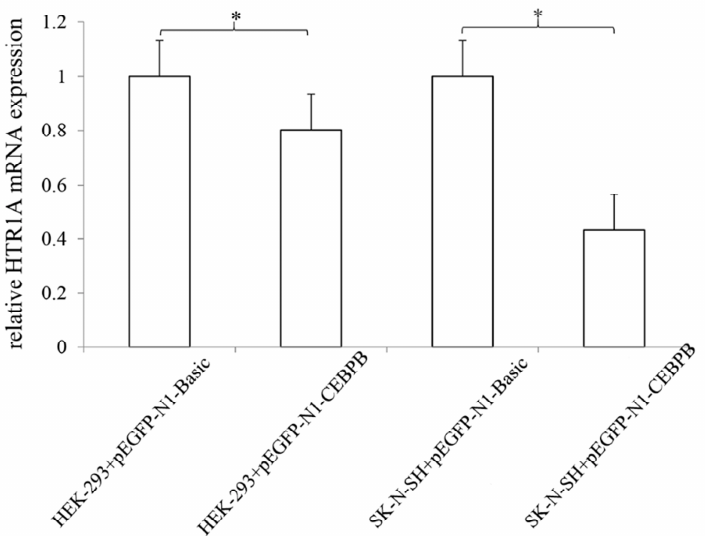
Figure 7. Inhibition e ff ect of CEBPB on the 5-HT1A receptor mRNA expression. The e ff ect of CEBPB on the expression of endogenous 5-HT1A receptor mRNA was detected by quantitative real-time PCR (qRT-PCR) and used the 2 − ∆∆ CT method for statistics. The results showed that CEBPB significantly inhibited the mRNA expression in both cell lines. * 0.02 < p < 0.05.